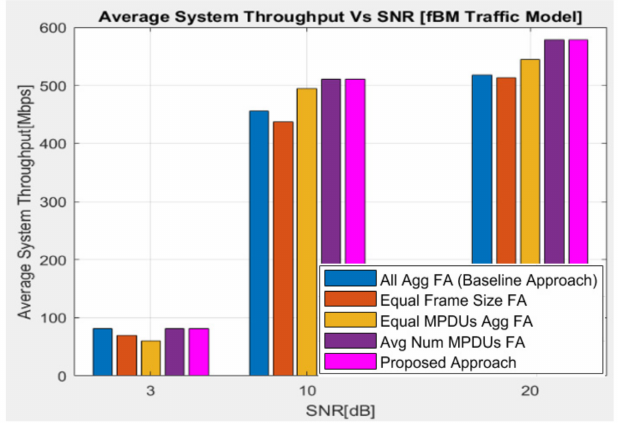
Figure 4. Average system throughput under varying SNR channel